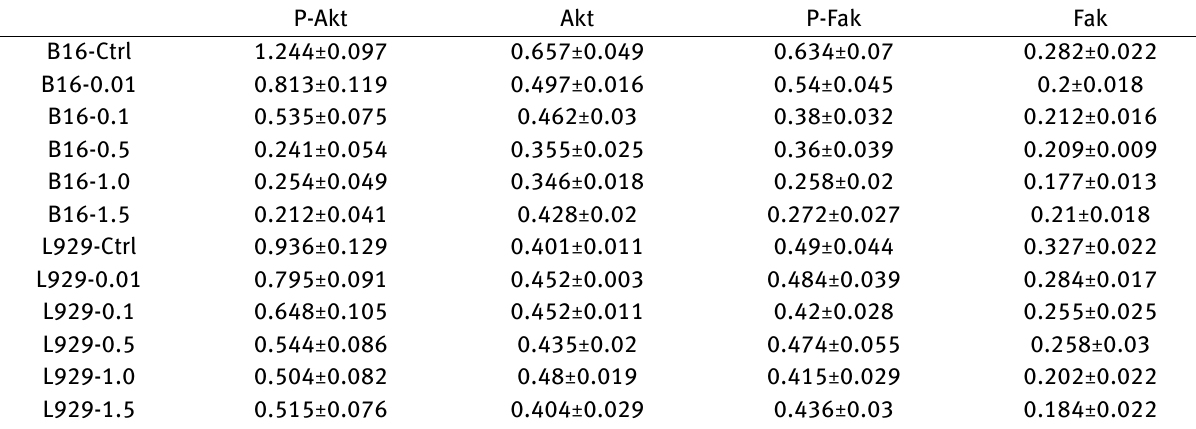
Table S3: Relative protein expression of P-Akt, Akt, P-Fak, Fak from Western-blot data (Mean ±